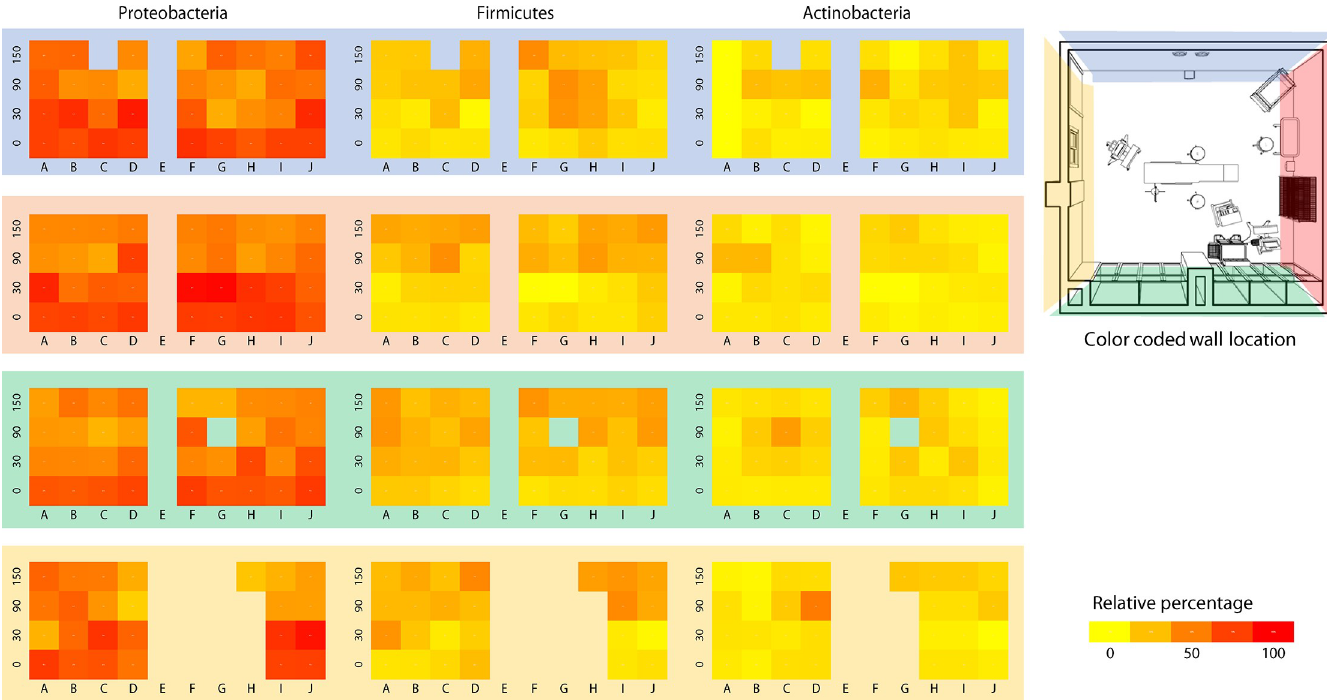
Fig 4. Representation of the relative abundance of bacteria from the most significant phyla on the four walls of the operating room. Each wall was subdivided into squares of 60 centimeters selected or swabbing, generating four rows that correspond to the levels 0 cm (floor), 30 cms, 90 cms, and 150 cms (measured from floor level to the center of each square). Each wall has been colored for reference, as seen in the top view of the operating room, as shown. We can see here the proportional variation connected to height variation for these walls, with a higher proportion of Proteobacteria the closer we get towards the level 0 cm (distant from the floor), and a proportional increment of both Firmicutes and Actinobacteria when we get farther away from the floor level.